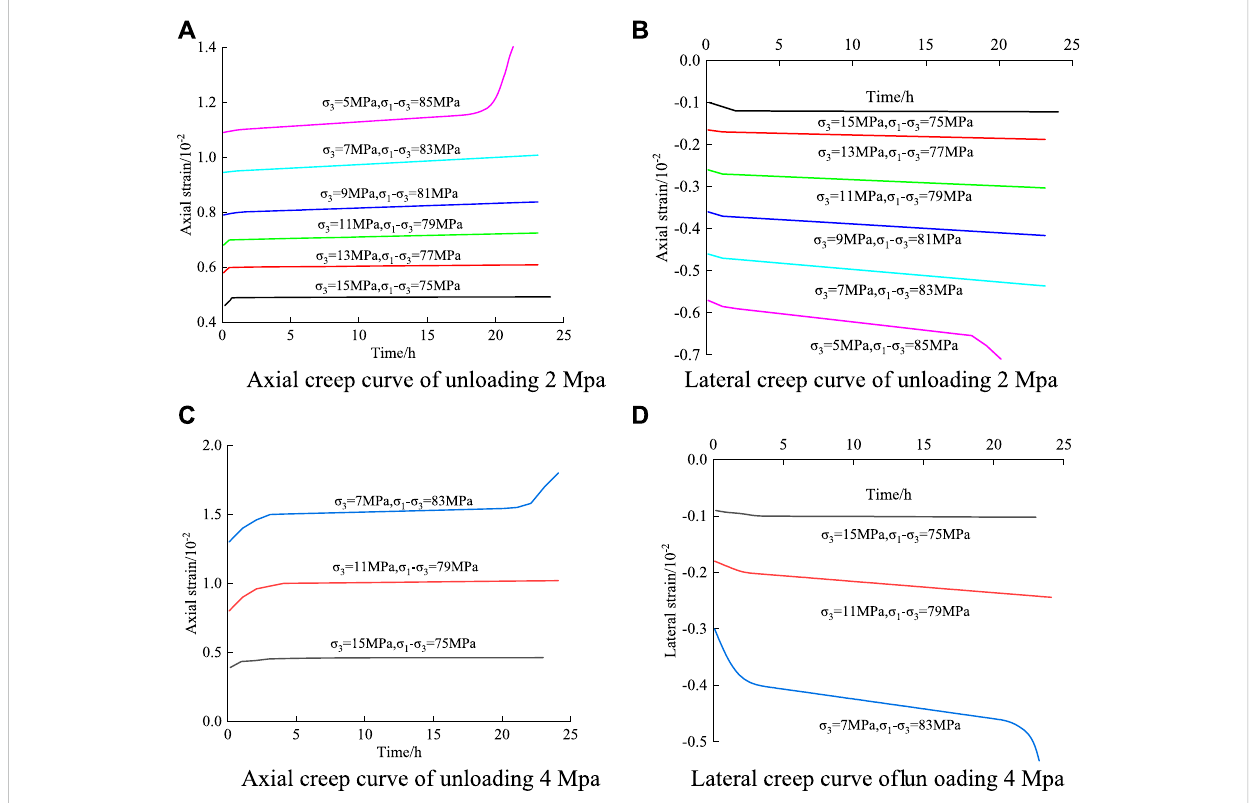
FIGURE 6 Triaxial unloading creep curve clusters of Flint limestone under different unloading amounts. (A) Axial creep curve of unloading 2 Mpa (B) Lateral creep curve of unloading 2 Mpa. (C) Axial creep curve of unloading 4 Mpa (D) Lateral creep curve of unloading 4 Mpa.